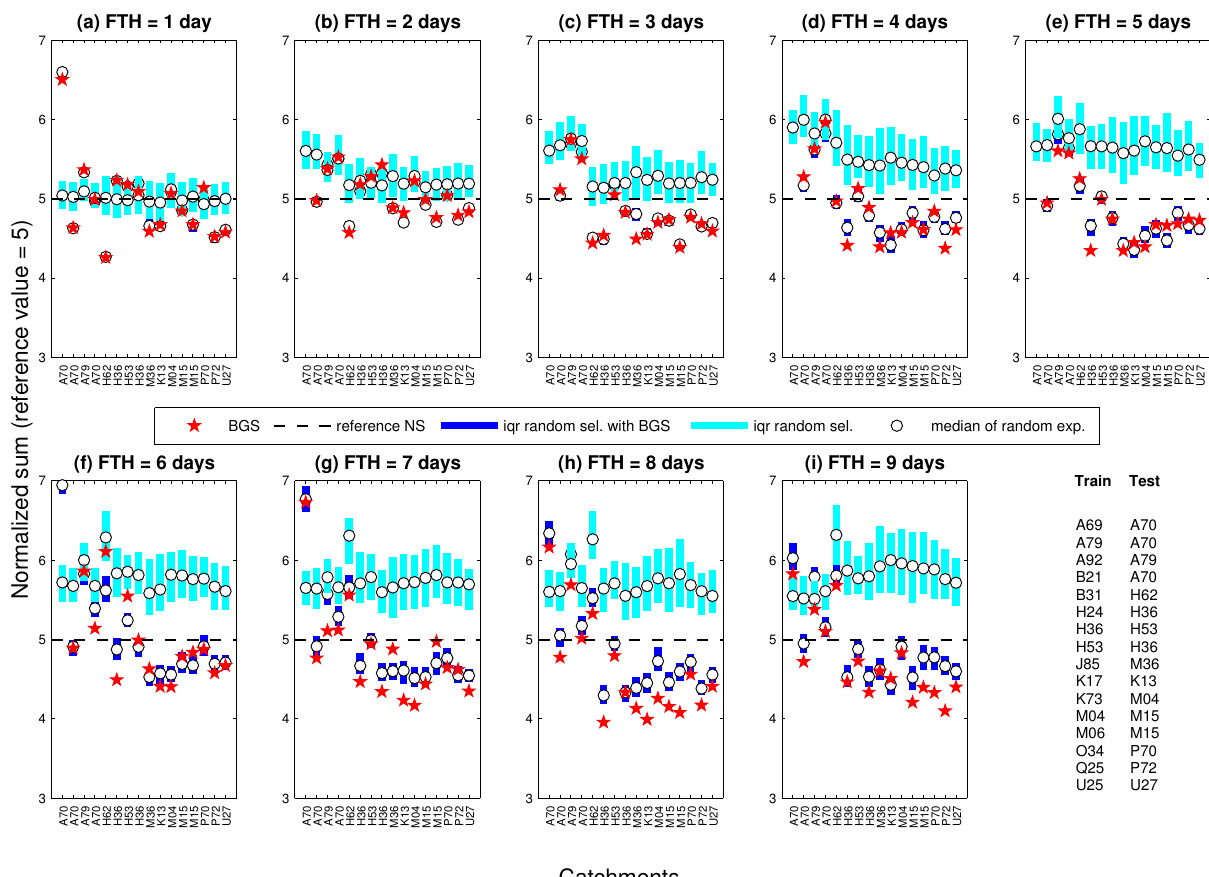
Fig. 6. Evolution of the normalized sum (NS) to evaluate the response sensibility of the extrapolation of results in the nearest catchments. Each vertical bar represents the interquartile range (iqr) of 200 combinations of 50 hydrological members under the following guidelines: the combination is oriented with the same proportion of hydrological models found with BGS-CV (blue vertical bars), the selection is completely random (cyan vertical bars). Note the deficiency of the selections’ extrapolation in basin A69 to basin A79, notably for early lead times (2 to 5 days); these results do not appear in the figure because they are above